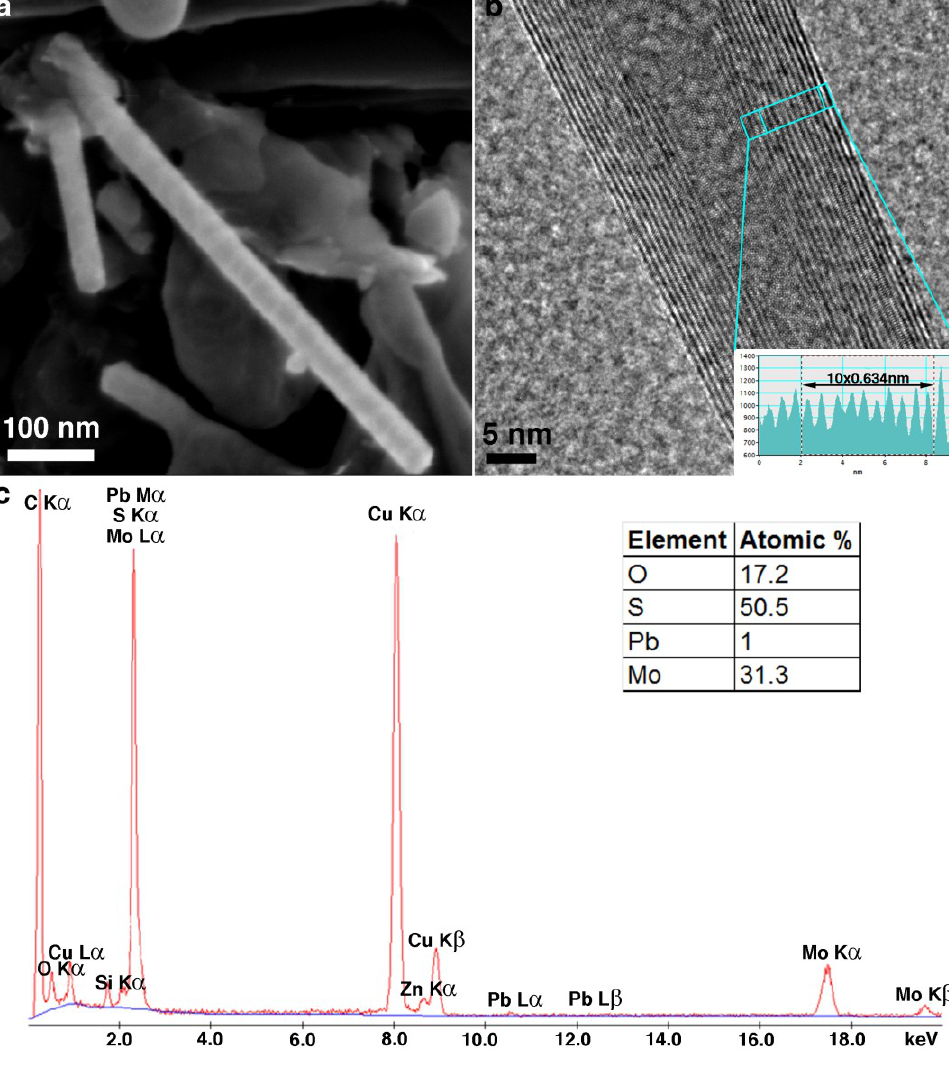
Figure 1. MoS nanotubes formed using solar ablation system ( a ) SEM image of MoS 2 nanotubes; ( b ) high resolution TEM image of a single MoS The inset shows the profile of the interlayer distances of the nanotube wall. The interlayer spacing is somewhat larger than that of bulk 2H-MoS